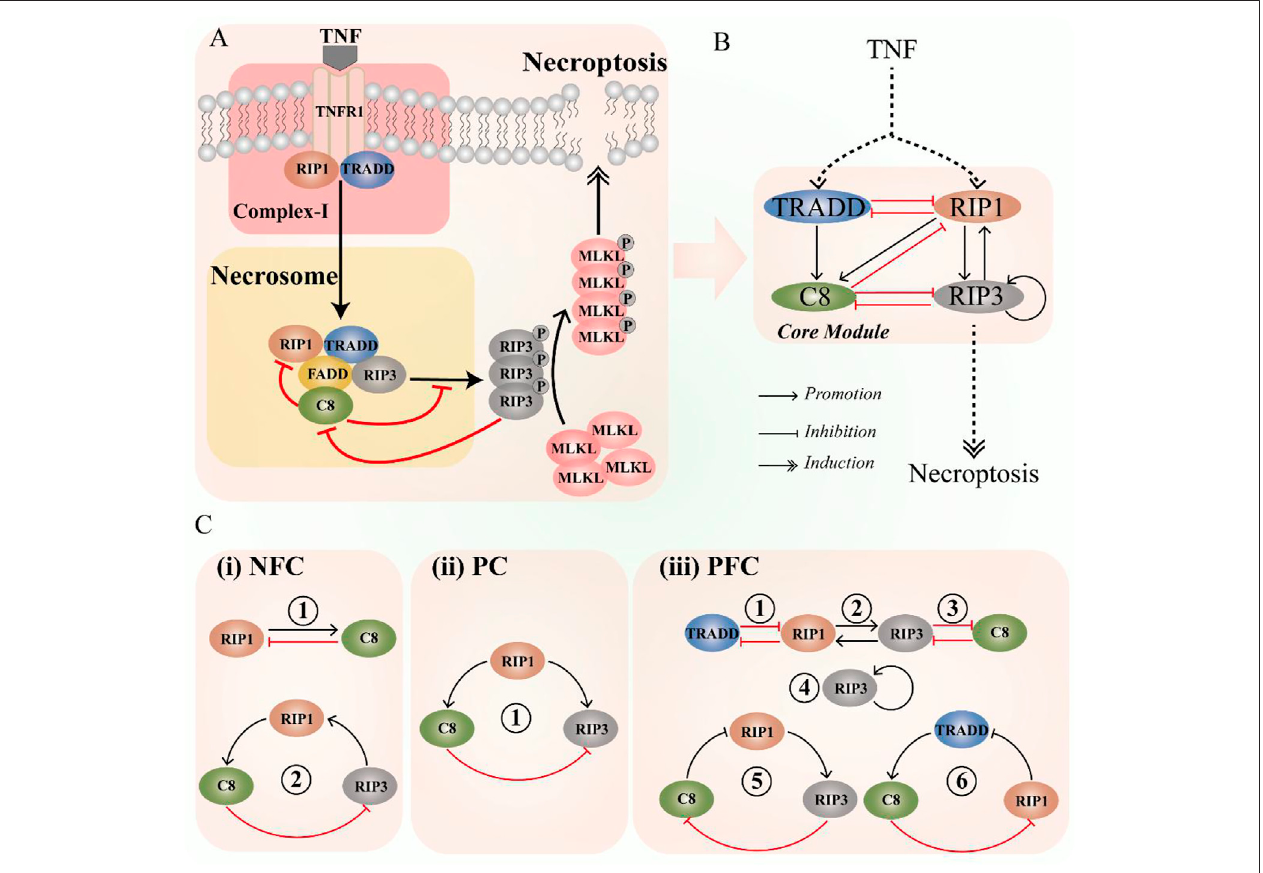
FIGURE 1 | Schematic diagram of the CNS pathway, highlighting the key components and interaction. (A) The CNS signaling pathway. (B) The coarse-grained CNScircuit. (C) Threetypesofsigni fi cantinteractionamongcomponentsinthecircuit,i.e.,negativefeedbackcomponents(NFC,contradictoryinteractionandfeedback loops), paradoxical components (PC, incoherent feedforward), and positive feedback components (PFC, self-activation, mutual activation or inhibition, and feedback loops).